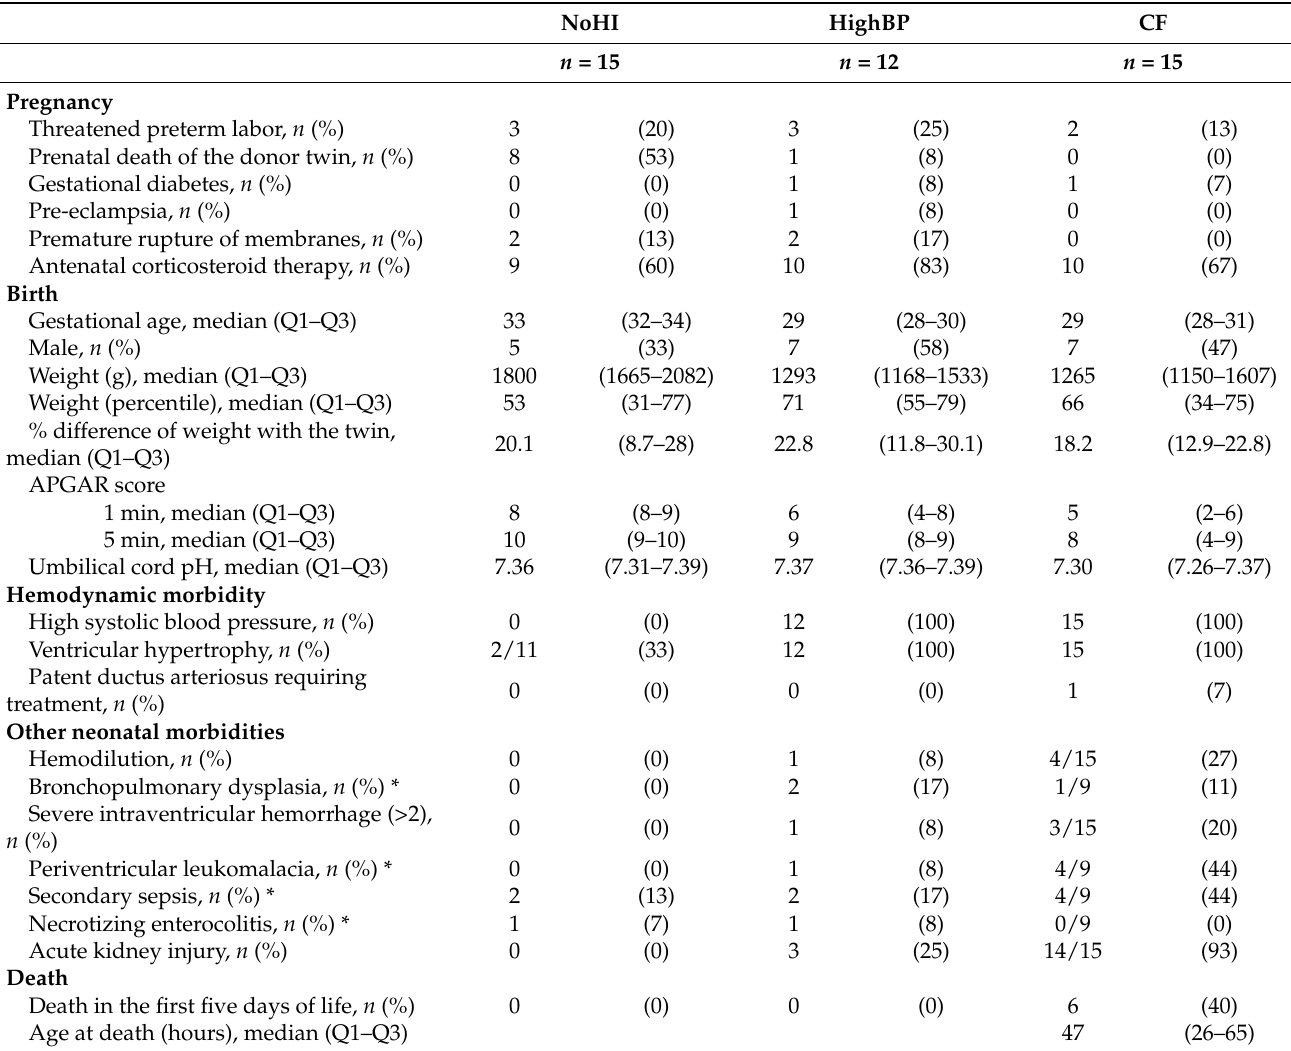
Table 1. General characteristics of the population divided into three groups according to the hemody- namic status during the first five days of life: no hemodynamic impairment (NoHI group), isolated high blood pressure (HighBP group), and cardiac failure (CF group). Data are presented as median values and 1st and 3rd quartiles or n (%). * Outcomes calculated in